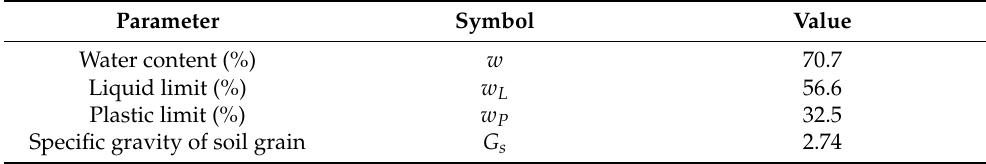
Table 3. Index properties of the sampled slurry.